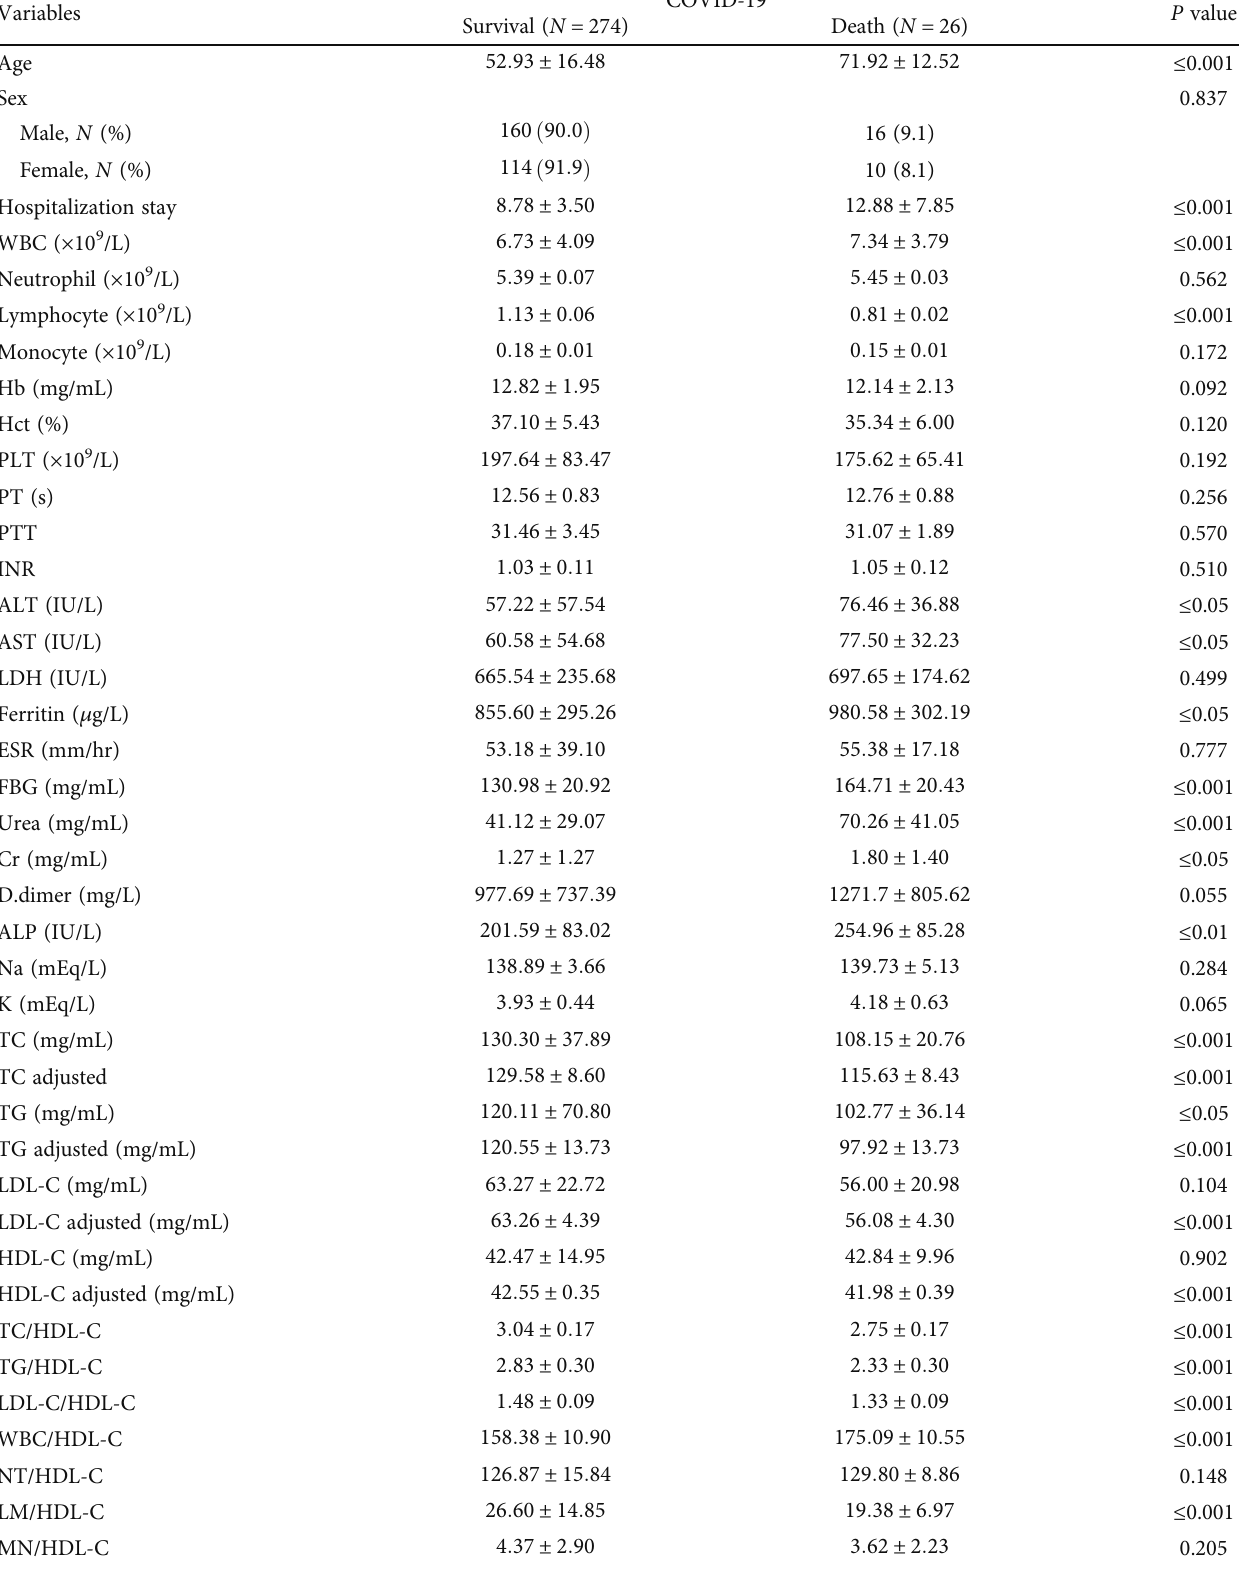
Table 2: Demographic, hematological, lipid pro fi le and its relative ratios of COVID-19 in survivor and nonsurvivor patients.